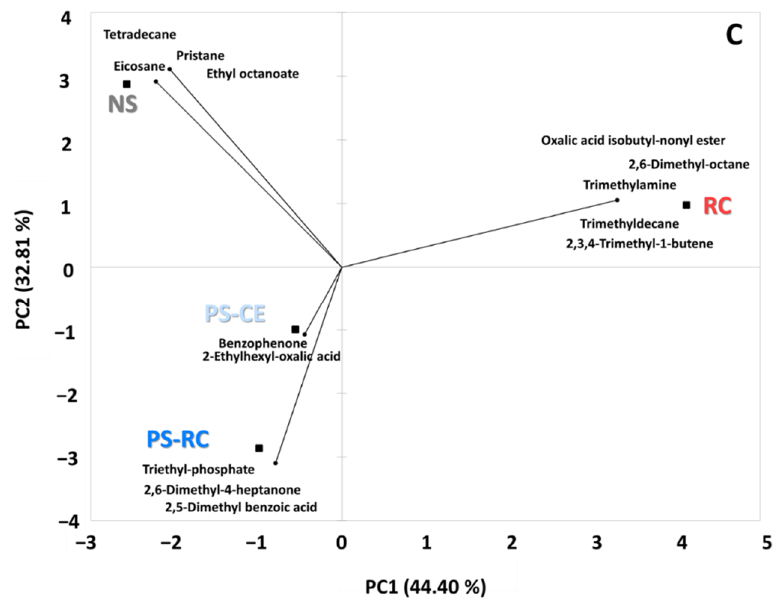
Figure 5. Principle component analysis of real snow crab ( C. opilio ) leg meat (RC) and commercial imitation crab sticks (ICSs) identified via electronic tongue ( A ), electronic nose ( B ), and GC-MS ( C ) testing. PS-RC, premium ICS with real red snow crab ( C. japonicus ) leg meat; PS, premium ICS without real red snow crab leg meat; NS, normal ICS. Table 6. Relative volatile compounds of snow crab leg meat and commercial imitation crab sticks as detected and quantified by